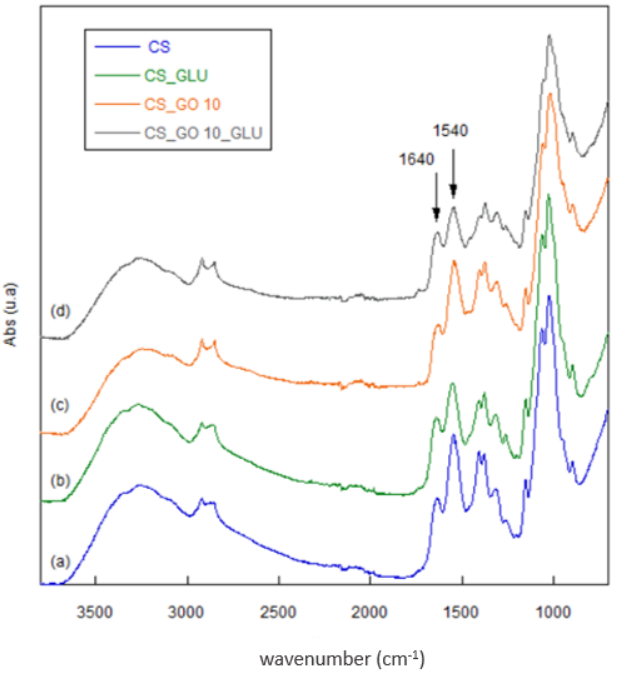
Figure 3. FTIR spectra of pristine CS ( a ), CS_GLU ( b ), CS_GO10 ( c ), and CS_GO10_GLU ( d ).